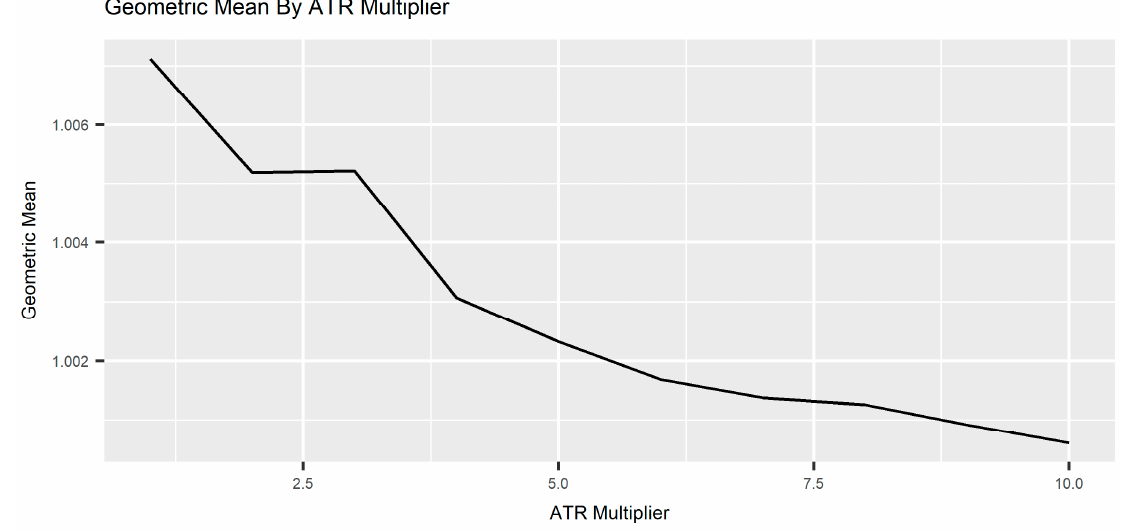
Figure 7. Performance impact of ATR multiplier .